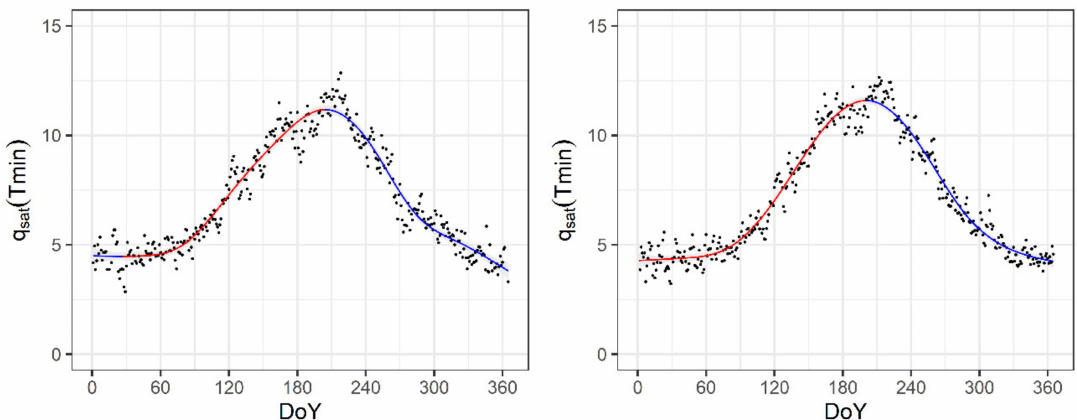
Figure 11. Seasonal variation of q sat ( T min ) (g kg − 1 ) in apple orchard (NS/CE; ( left )) and winter wheat/sugar beet canopy (NS/TE; ( right )).